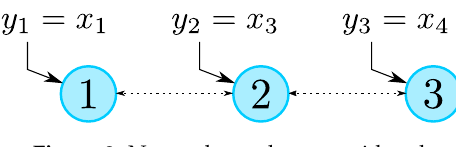
Figure 2. Network topology considered.